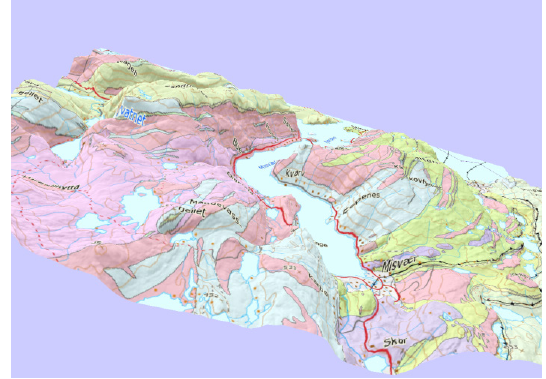
Figure 12: Bedrock N50 (Salten, Nordland).